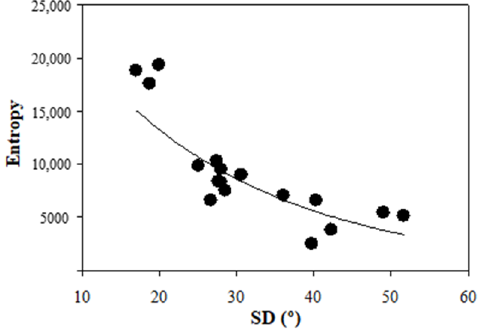
Figure 7. Entropy values as a function of SD for all images considered herein.